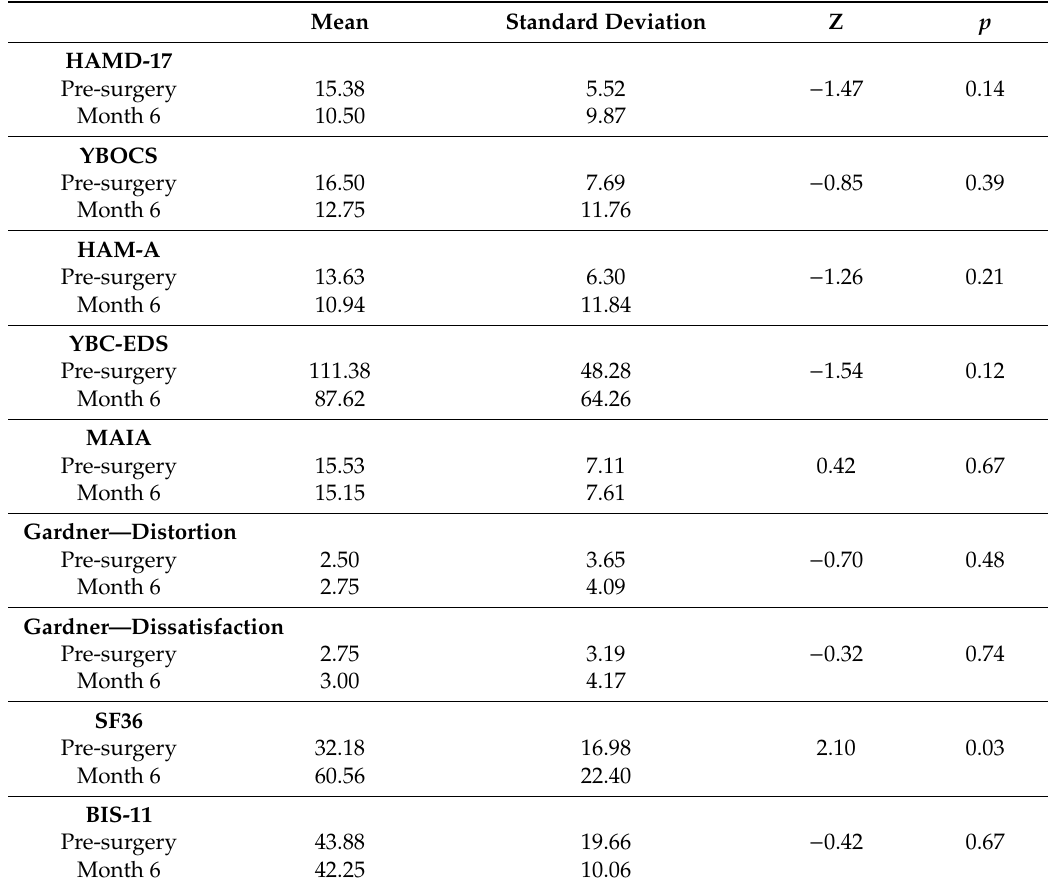
Table 3. Wilcoxon signed-rank test for secondary outcomes measured preoperatively (baseline) and at month 6 of follow up. Mean Standard Deviation Z